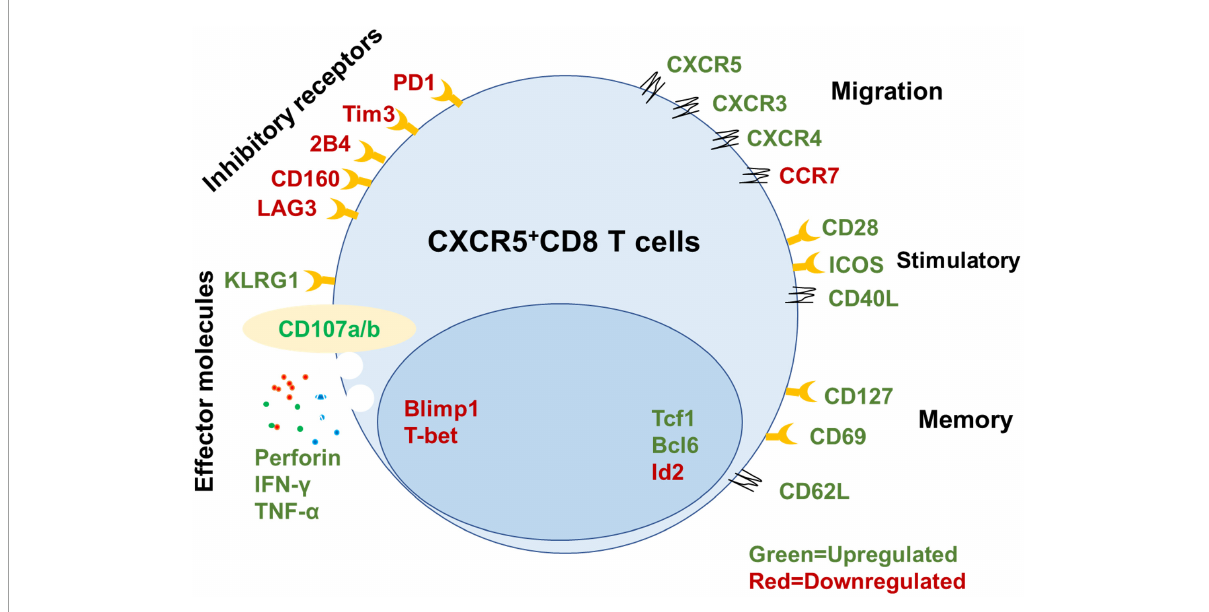
FIGURE1 Signatures of mouse CXCR5 + CD8 + T cells. Summary of key functional molecules in CXCR5 + CD8 + T cells in lymph tissues (inhibitory receptors, migration, stimulatory, and memory) and peripheral blood compared with CXCR5 − CD8 + T cells based on published data (He et